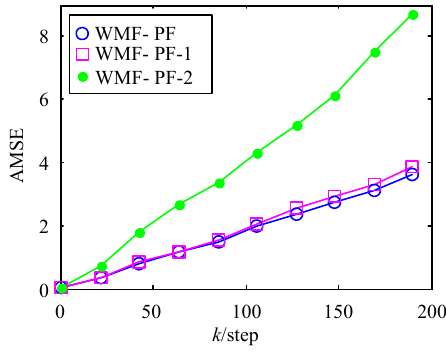
Figure 5. AMSE curves of WMF-PF, WMF-PF-1, and WMF-PF-2.